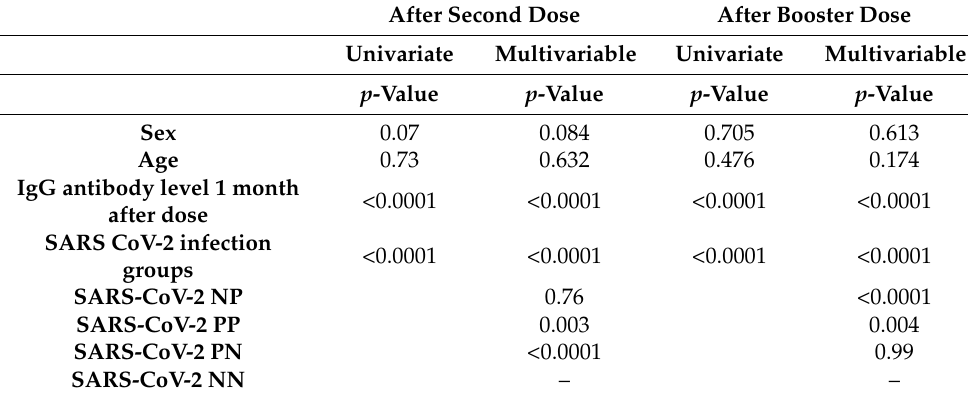
Table 2. Univariate and multivariable linear regression to evaluate the 3-month difference in absolute variation of IgG-Trimeric Spike antibody levels starting from 1 month after dose 2 (D2M1) or 1 month after booster dose (BDM1). After Second Dose After Booster Dose Univariate Multivariable Univariate Multivariable p -Value